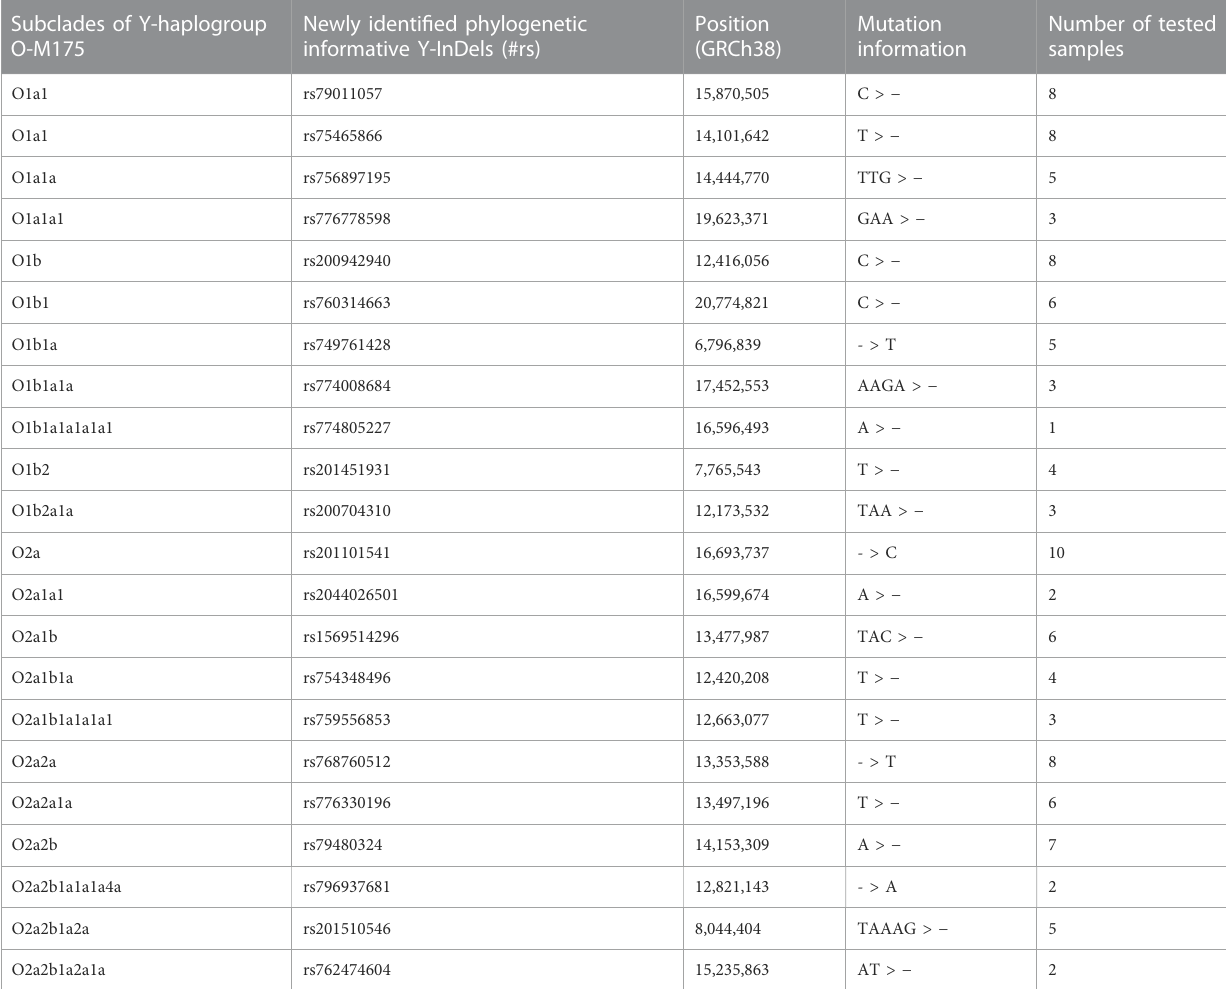
TABLE 1 The summary of phylogenetic informative Y-InDels and corresponding subclades in haplogroup O-M175. Subclades of Y-haplogroup